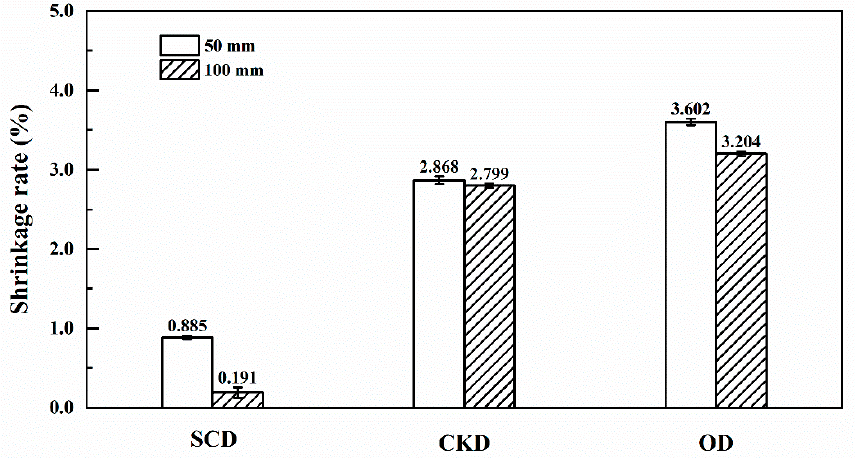
ff erent drying